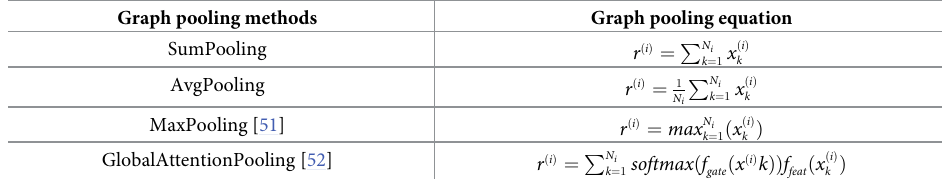
Table 3. Common graph pooling